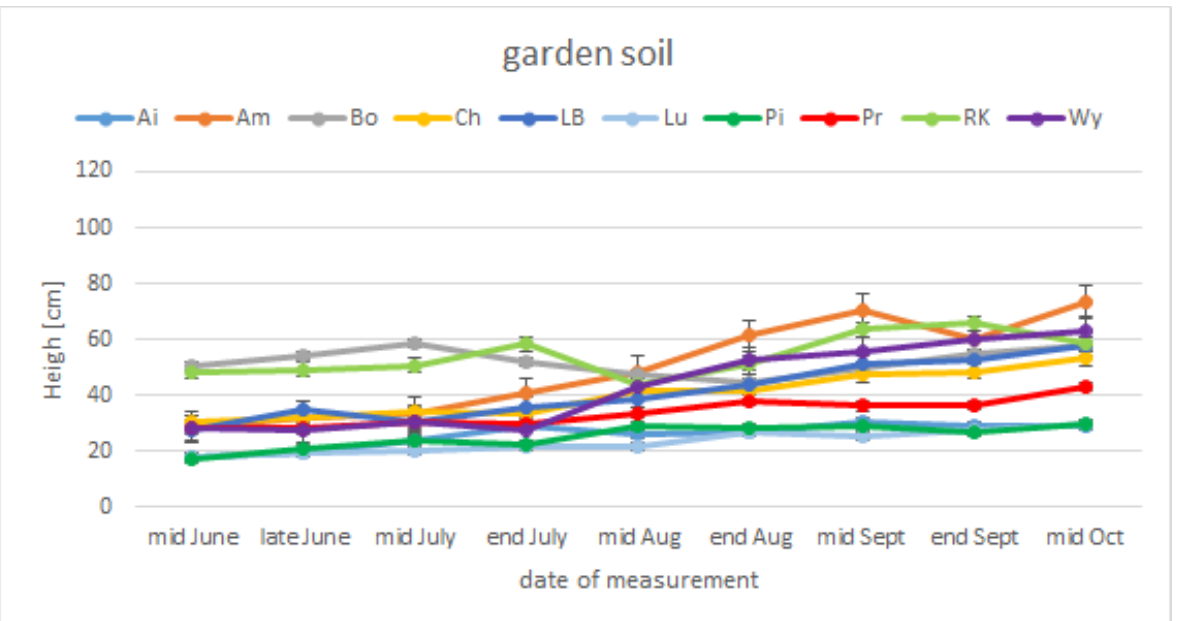
Figure 3. Dynamics of canna growth on garden soil. Description of cultivars is given in Materials and Methods Section 2.1. The means ± SE is expressed by each value.